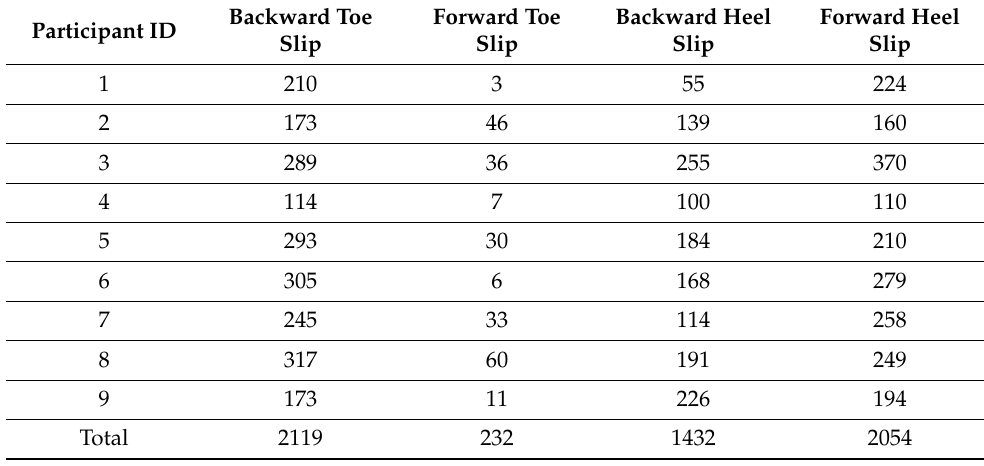
Table 4. Number of slips collected by type and participant, identified through visual